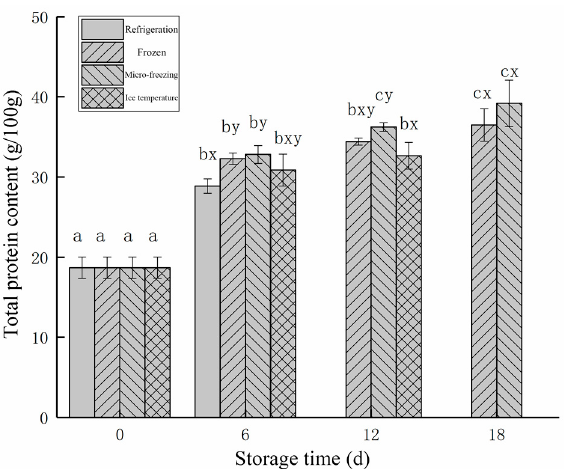
Figure 6. Changes in the total protein content of beef stored in different low-temperature storage methods. d, day.